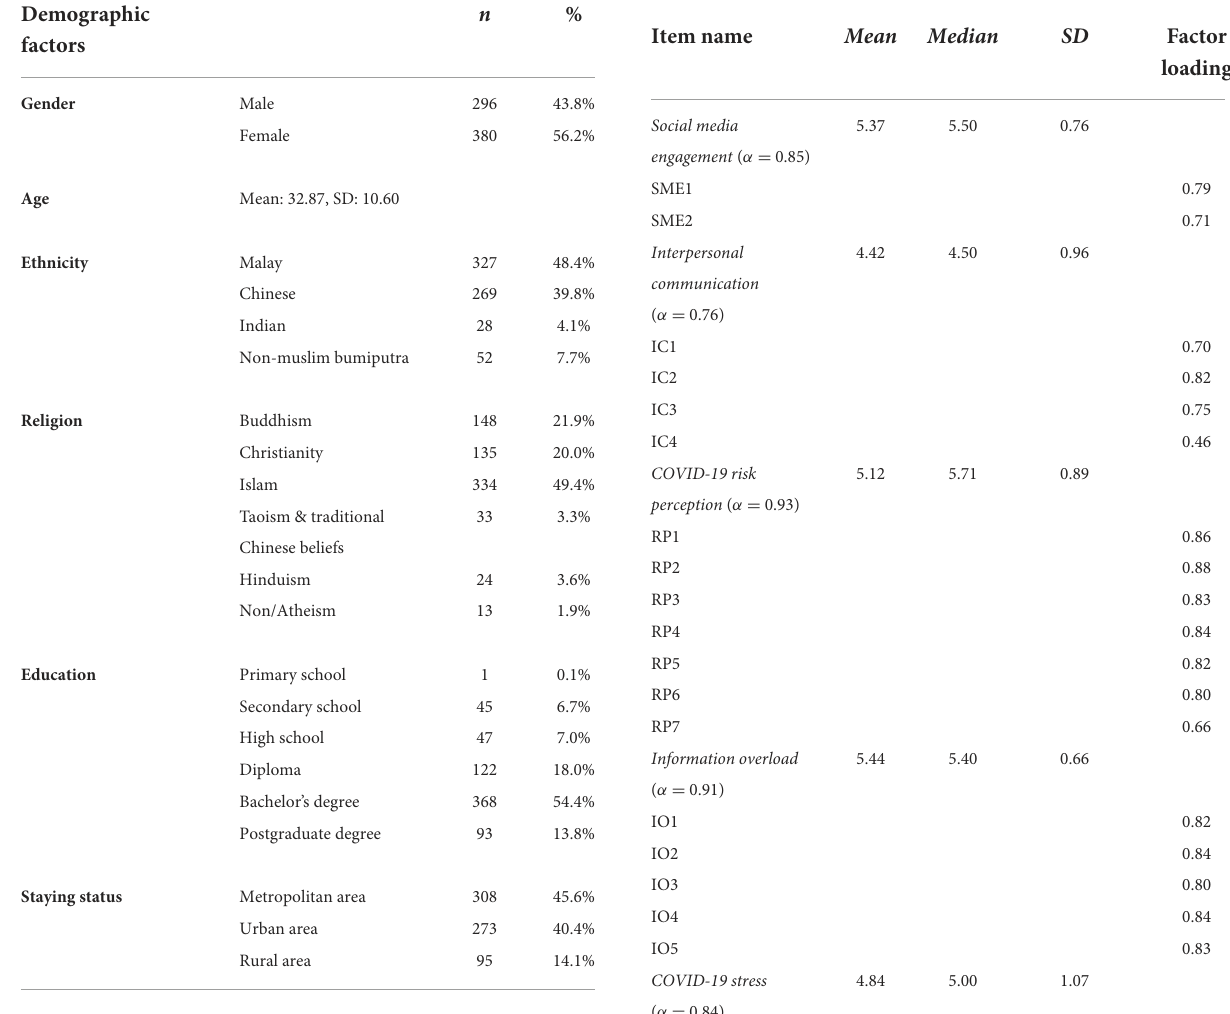
TABLE 1 Demographic information of the respondents ( N = 676). TABLE 2 Descriptive statistics and confirmatory factor analysis (CFA) of measured